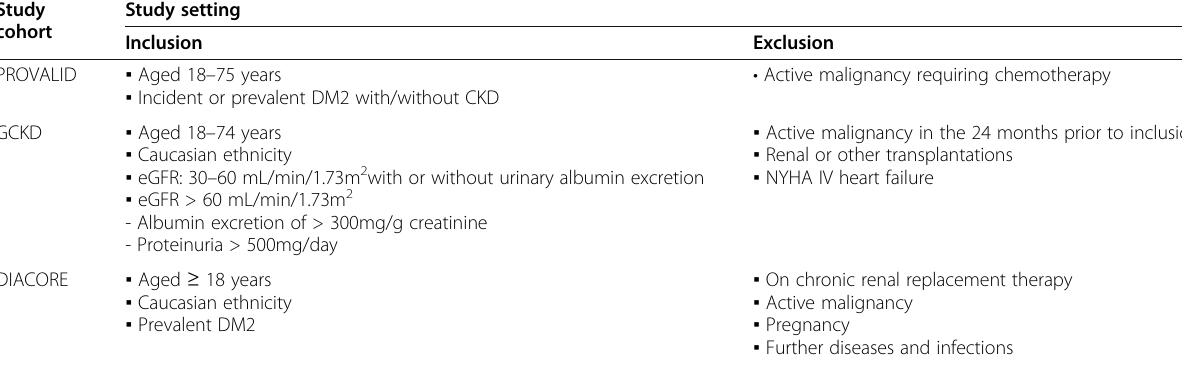
Table 1 Overview of the inclusion and exclusion criteria of PROVALID, GCKD, and DIACORE Study